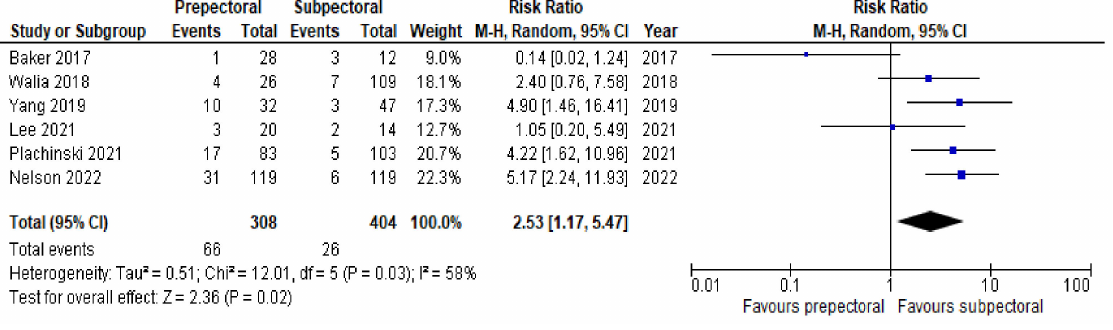
Figure 3. Seroma [14,16,17,20–22].